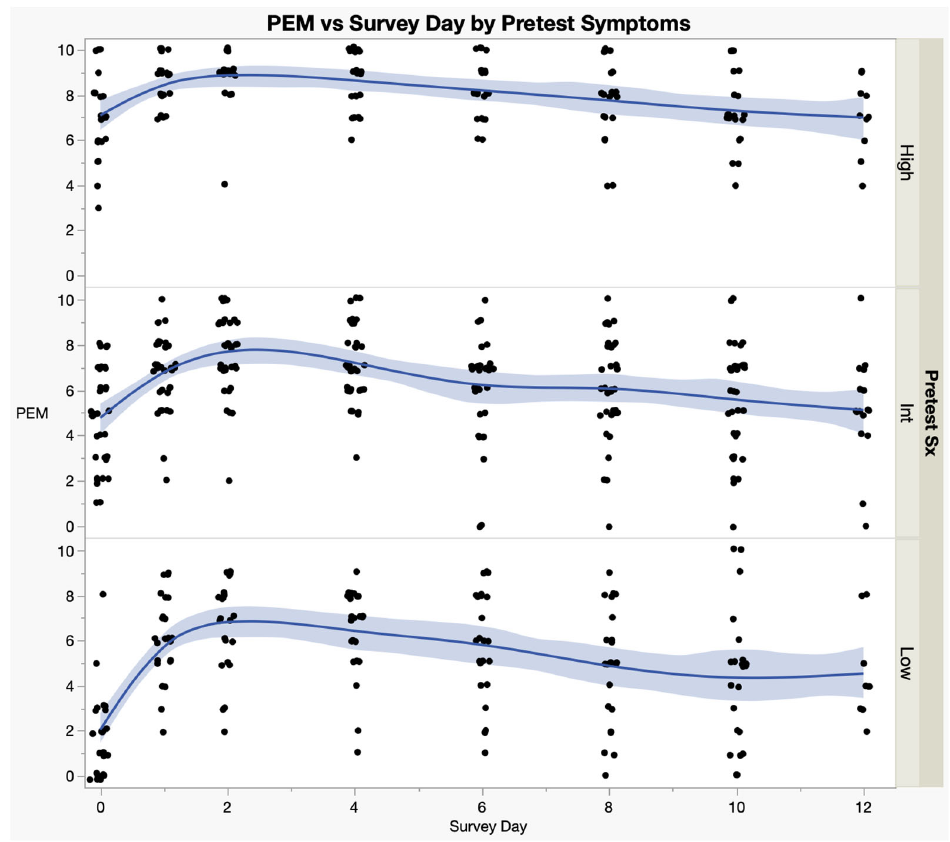
Figure 6. Post-Exertional Malaise (PEM) Recovery by Level of Baseline Symptoms. PEM domain scores of the SSS instrument by the severity of pre-test symptoms: High, Intermediate (Int) or Low—ME/CFS only. Each dot is the mean PEM score for an individual ME/CFS subject; Blue lines are the spline curves representing the average of all data points in each subgroup; Light blue areas are the 95% confidence intervals.